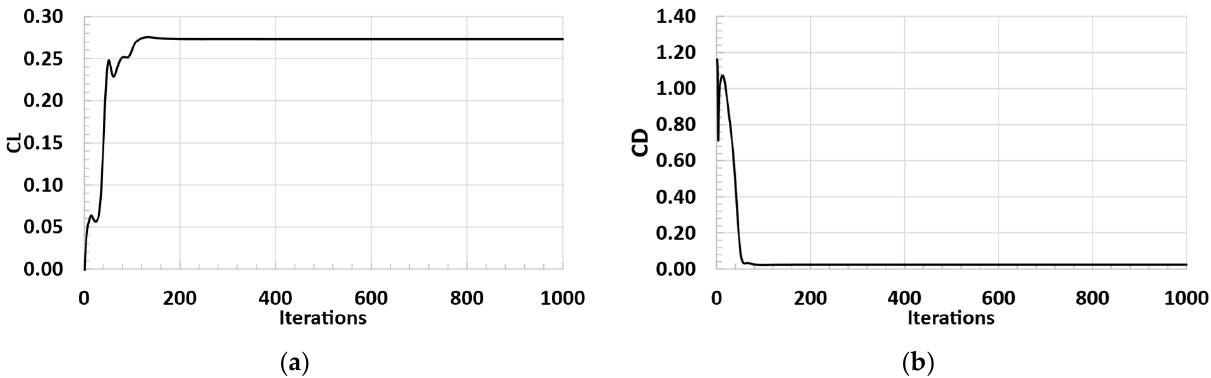
Figure 3. Convergence plot for lift coefficient ( a ) and drag coefficient ( b ). Cruise condition, M = 0.32, Re = 9.2 Mil.